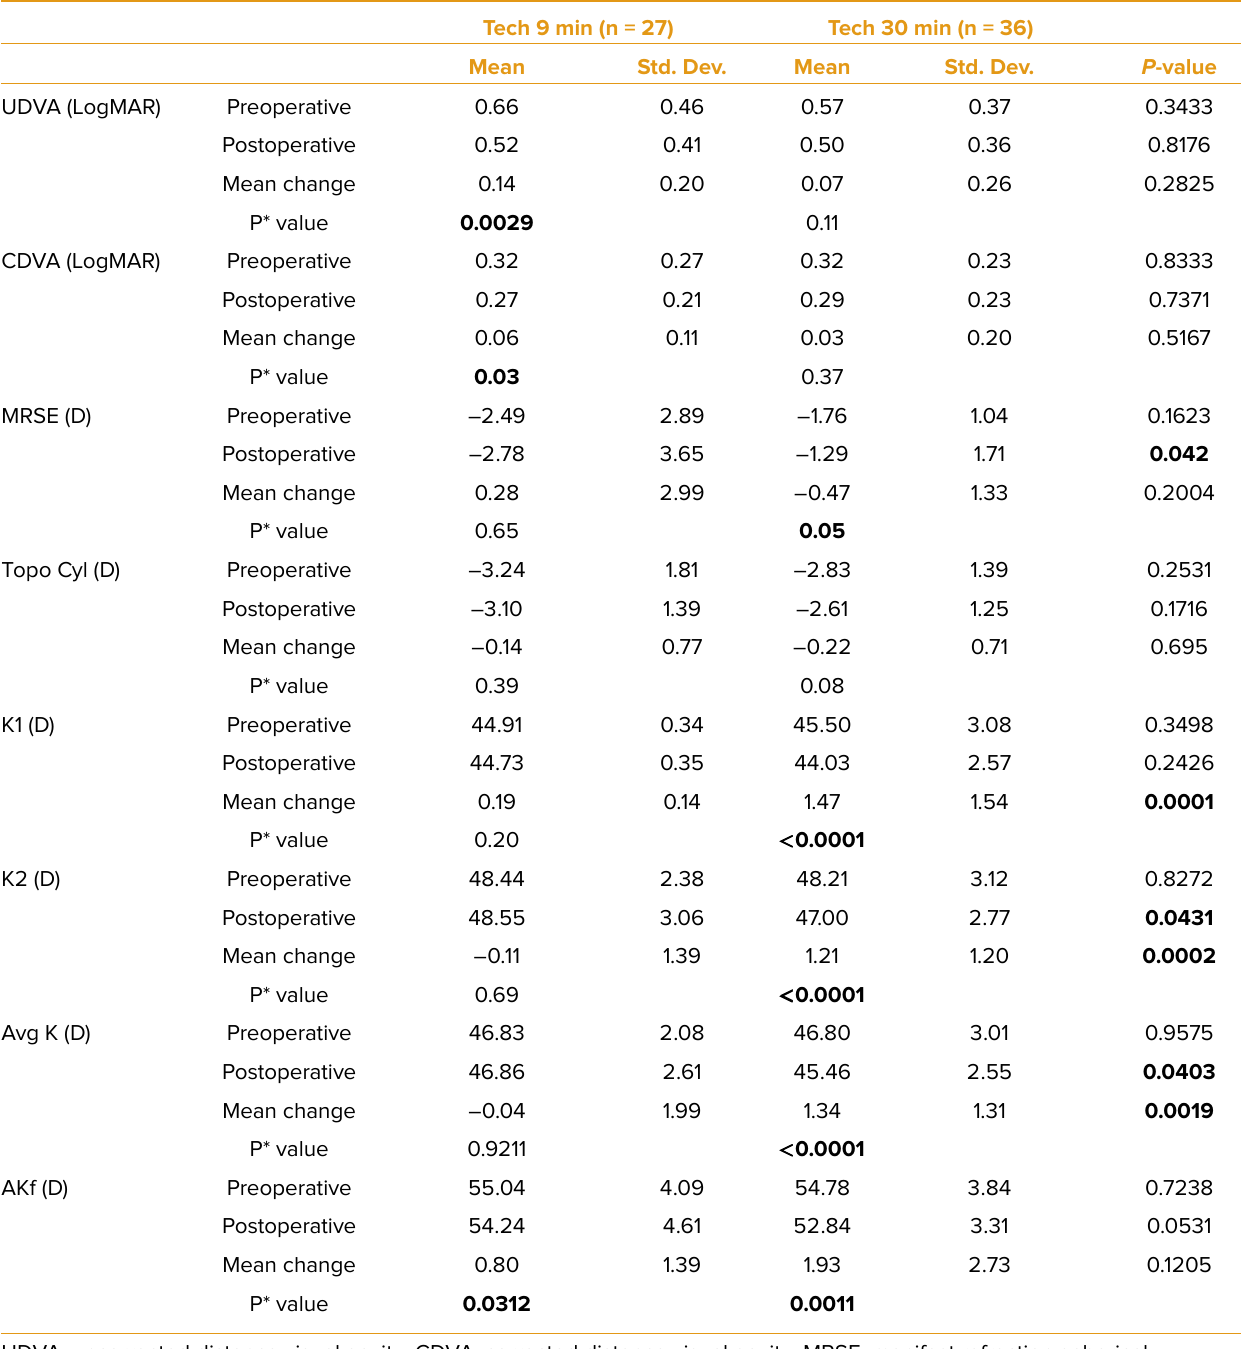
Table 2. Visual, refractive, and anterior keratometric